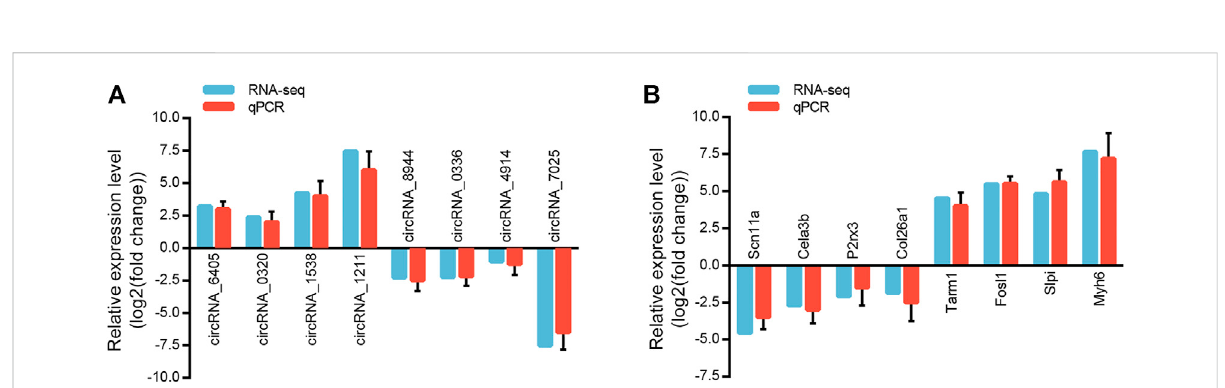
FIGURE 4 Validation ofrandomlyselected circRNAs and mRNAs. (A) qRT-PCRanalysisofeight randomlyselectedcircRNAs ( n = 3for RNA-seq; n = 10for qRT-PCR).TheY-axisrepresentstheratiooftherelativeexpressionofcircRNAsintheLSRAgrouptothatoftheShamgroup. (B) qRT-PCRanalysisof eight randomly selected mRNAs ( n = 3 for RNA-seq; n = 10 for qRT-PCR). The Y-axis represents the ratio of the relative expression of mRNAs in the LSRA group to that of the Sham group. circRNAs, circular RNAs; mRNAs, messenger RNAs; qRT-PCR, quantitative real-time polymerase chain reaction; LSRA, lumbosacral spinal root